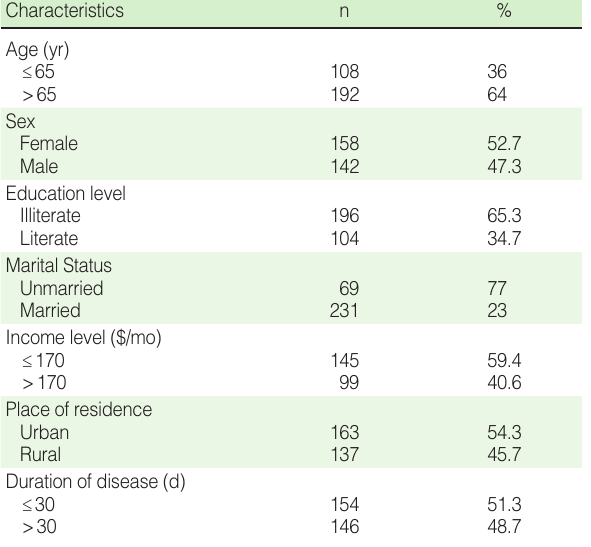
Table 1. Characteristics of the study population (n=300) Characteristics